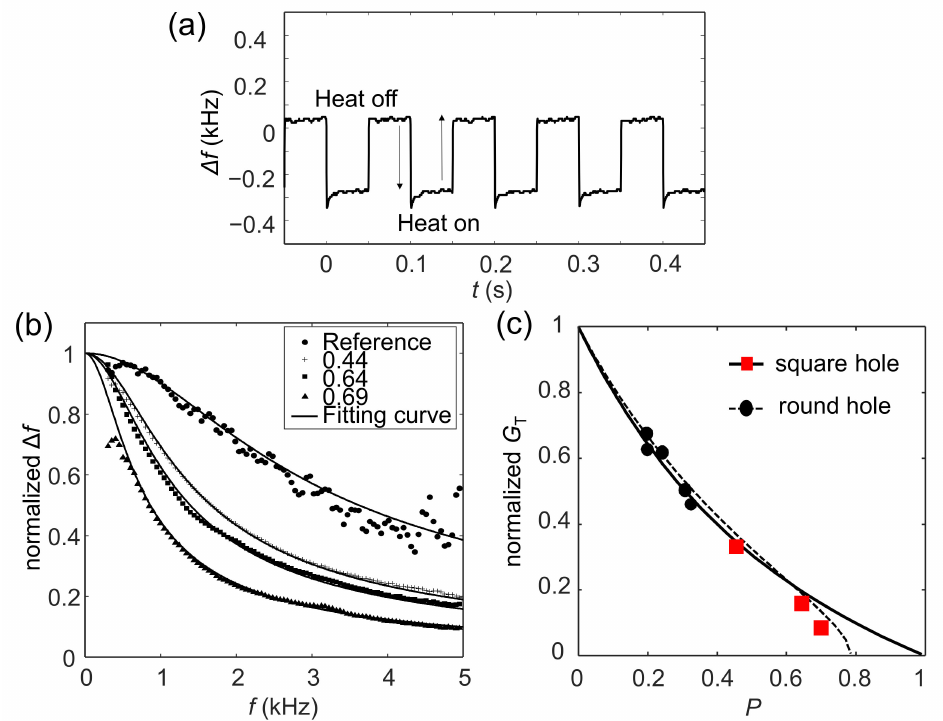
Figure 4. ( a ) The shift in the resonance frequency ( ∆ f ) when the laser was periodically modulated. ( b ) ∆ f measured by using a lock-in amplifier as a function of the modulation frequency of the laser. The solid dots, plus signs, square signs, and triangle signs indicate the normalized ∆ f for the reference beam, and nanomesh beams with P = 0.44, 0.64, and 0.69, respectively. The solid line shows the curves of fitting with the experimental data. ( c ) The red squares show the normalized thermal conductance of MEMS beams with the porous nanomesh. The black dots show the thermal conductance at small P with the round hole array structure. The theoretical values calculated with the finite element methods are plotted as the solid and dashed curves for the nanomesh (square hole) and the round hole designs,